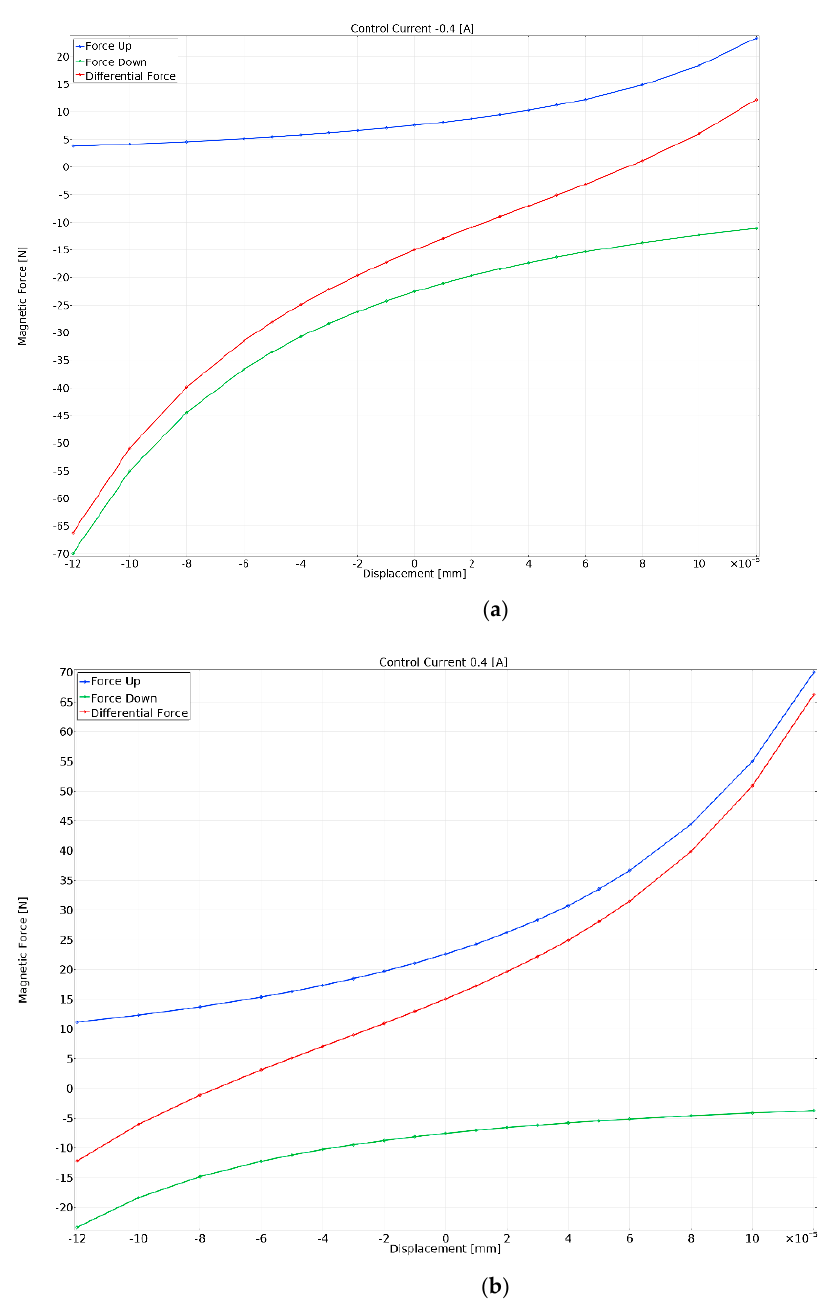
Figure 15. Magnetic forces for the control current of -0.4 A ( a ) and 0.4 A ( b ).